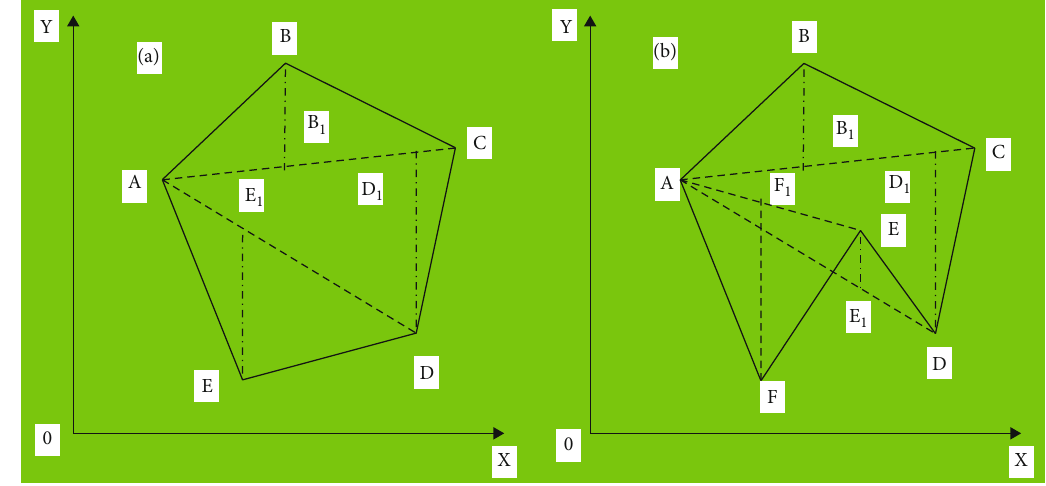
Figure 2: Schematic diagram of convex and concave in coalface [45]: (a) convex; (b) concave. Table 1: Damage grade of brick-concrete structures